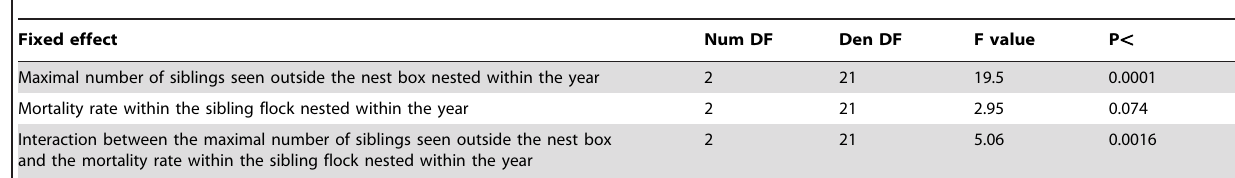
Table 3. The results of the GLMM for the Individual duration of